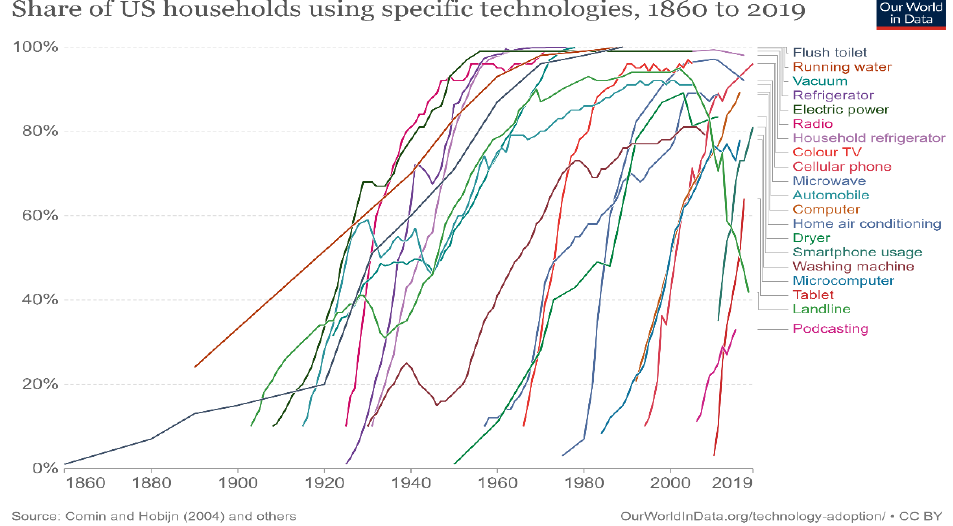
Figure 4. The rate of TA in US households from 1860 to 2019. Source: https://ourworldindata.org/technology-adoption (accessed on 1 July 2022).